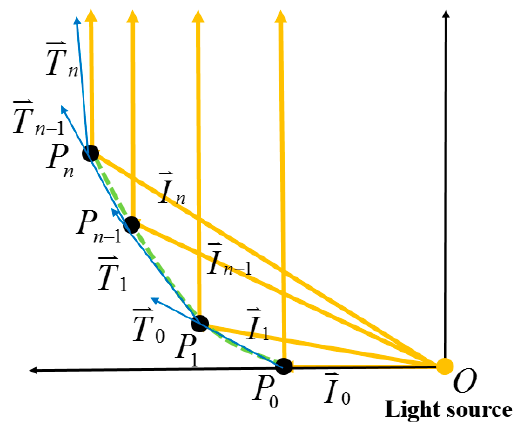
Figure 5. The process for constructing the freeform reflection surface.